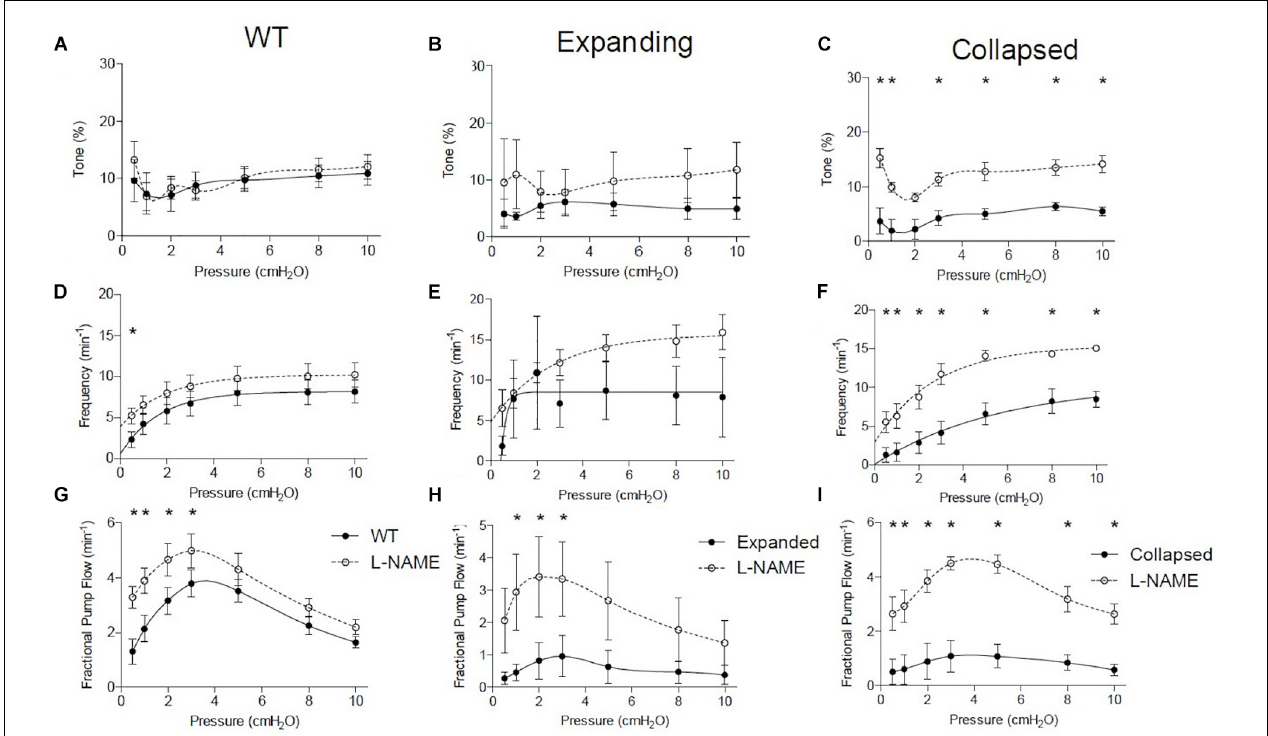
FIGURE 3 | Collapsed lymphatic vessels display distinct nitric oxide-dependent functional defects ex vivo . The lymphatic vessels described in Figure 1 were treated with and without L- NAME (10 − 4 M), and their tone, contraction frequency and fractional pump flow vs. pressure were determined ex vivo . All data are means ( ± SEM). When error bars appear missing, they are actually contained within the data points (* P < 0.05 vs. L-NAME at the same pressure). Note that L-NAME has very limited effects on vessels afferent to WT and Expanding PLN, but restores tone, frequency, and fractional pump flow in lymphatic vessels afferent to Collapsed PLN at all pressures